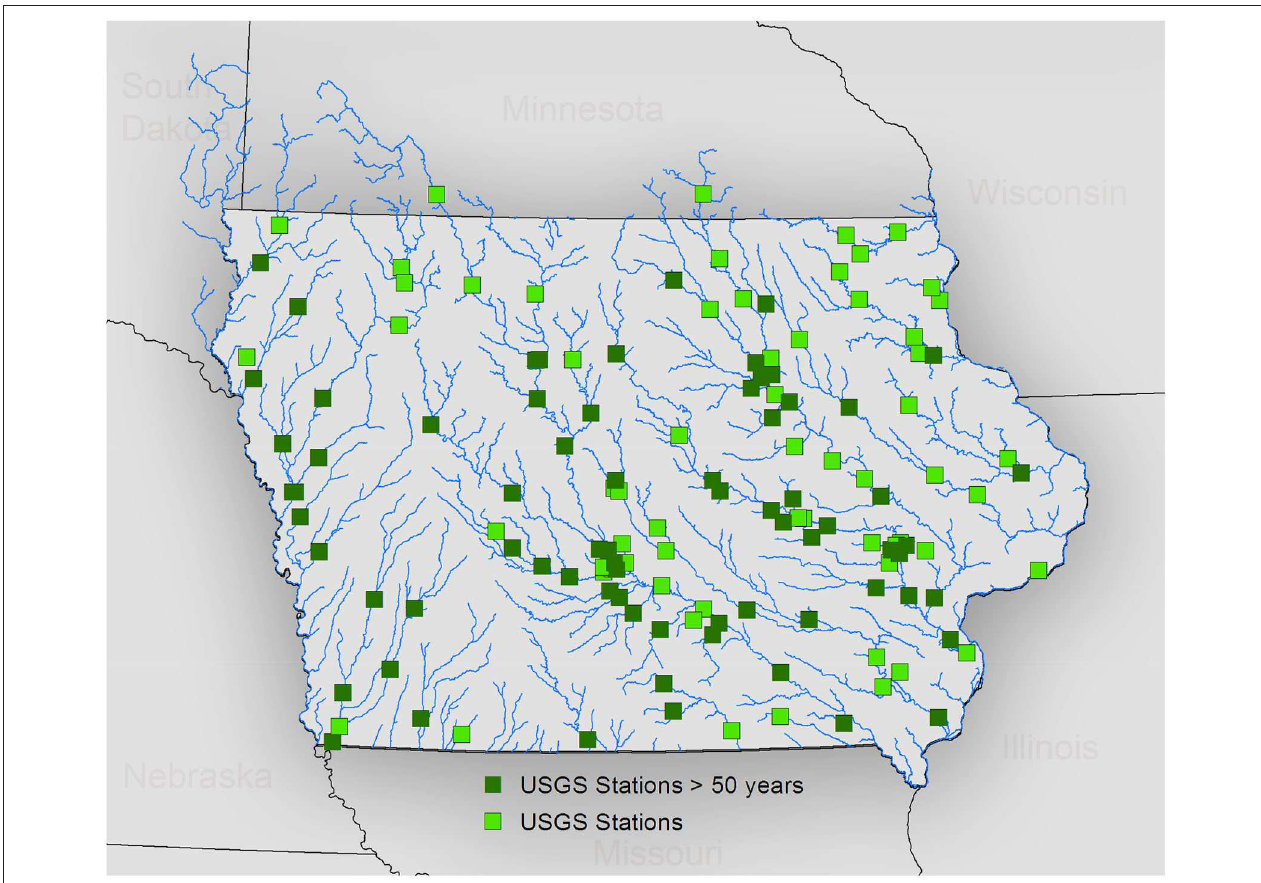
FIGURE 2 | Spatial distribution of USGS stations (both light and dark green squares) across Iowa. The dark green squares represent USGS stations with at least 50 years of streamflow records.